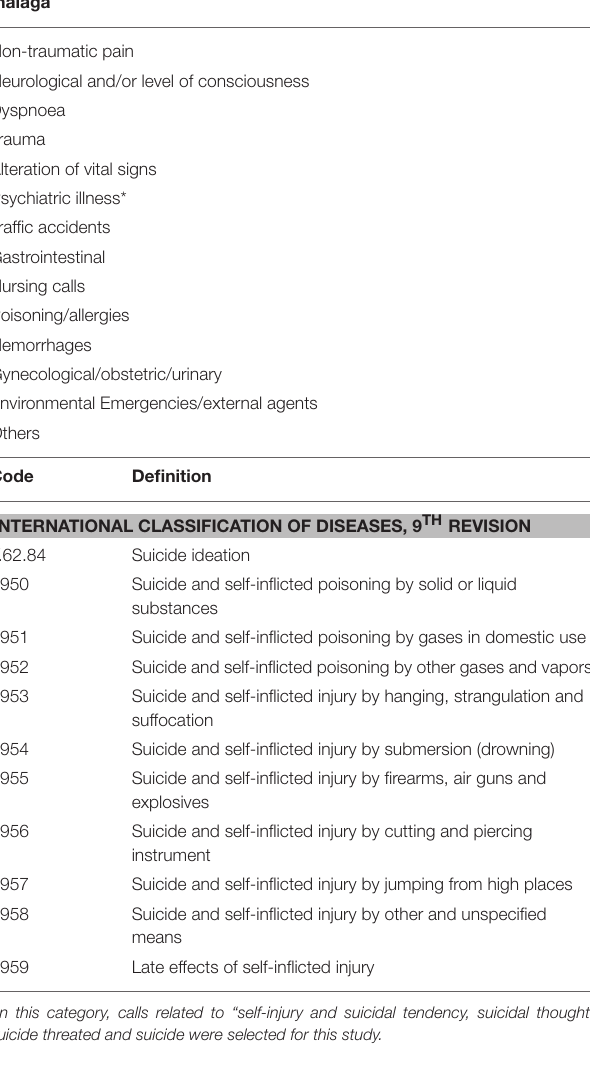
TABLE 1 | Classification of the Urgencies and Emergencies Coordinating Center of Malaga and classification of suicidal behaviors according to the International Classification of Diseases